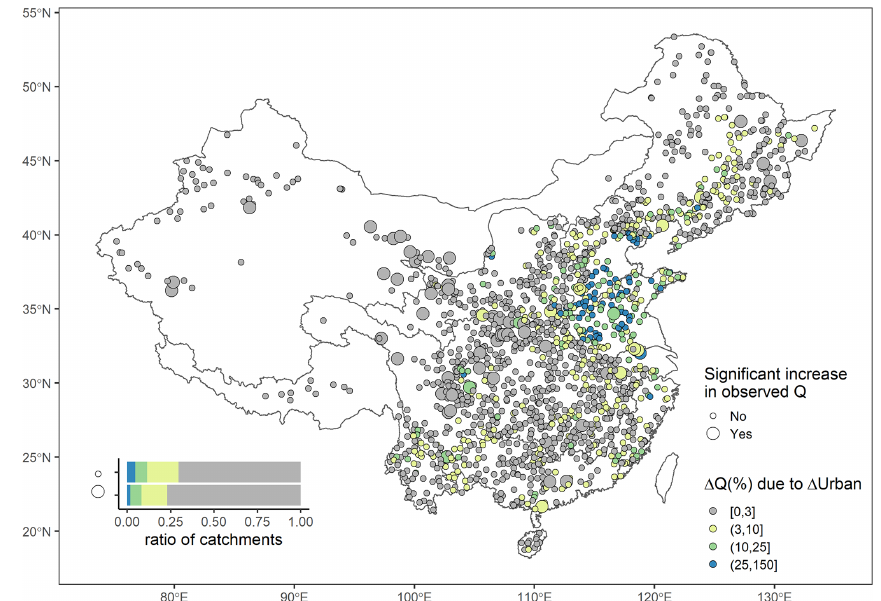
Figure 6. Accumulated increases in annual maximum discharges ( Q ) due to the increases in urban areas (Urban) for 1625 catchments with at least 20 years of flood data in 1992–2017, according to Eq. (6). Large dots represent catchments with significant increases in observed Q if p < 0 . 05 for either one of the Mann–Kendall test and the Pettitt’s test. The boundary lines delineate nine major river basins of